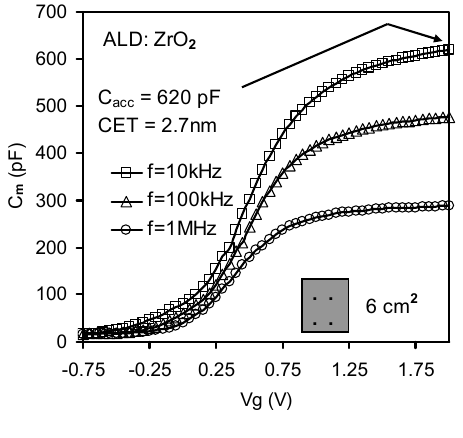
Figure 4. Presence of frequency dispersion in ZrO (10kHz, 100kHz and 1MHz). The shadowed boxes indicate the presence of metal Al contact at the back of silicon substrates with an effective area of 6 cm 2 and the capacitance equivalent thickness (CET) is 2.7 nm. C range